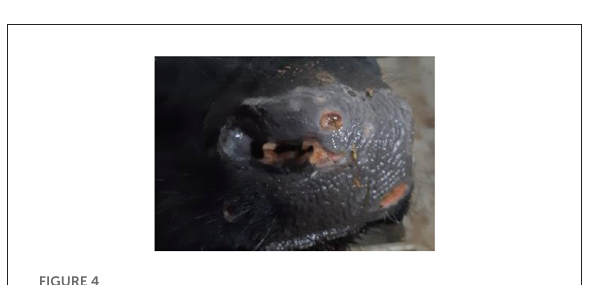
FIGURE2 Clinical manifestation of LSDV in bull No. 5 belonging to the IN group. (A) Nodular skin lesions, 10 dpi. (B) Nodular skin lesions, 16 dpi.